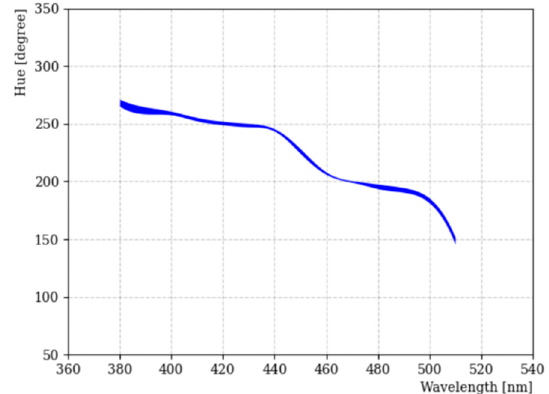
Figure 6. H–W curve with Canon EOS 450D using CFA technology. The thickness of the line indicates the deviation of hue across the limited dynamic range of the camera for the wavelength from 380 nm to 520 nm .